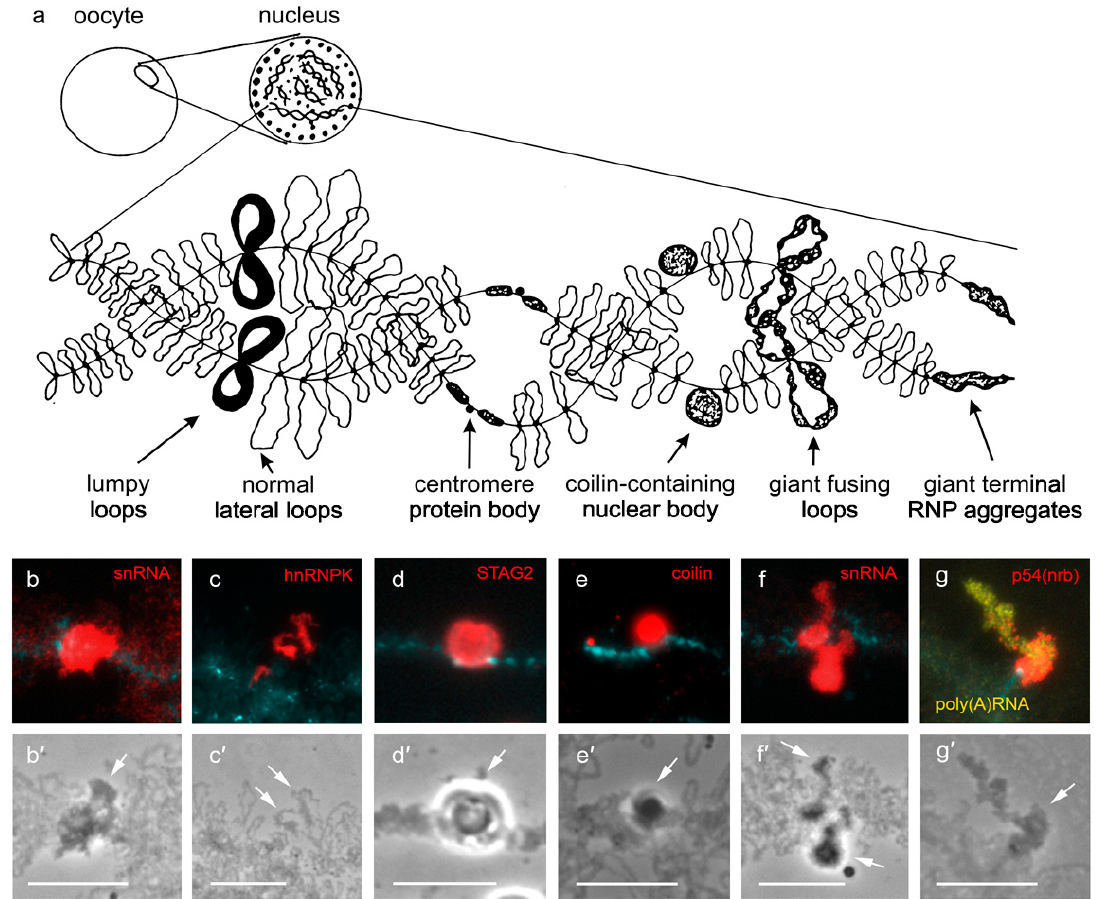
Figure 1. Locus-specific nuclear domains on lampbrush chromosomes. ( a ) Schematic drawing of a lampbrush chromosome with various locus-specific nuclear bodies and domains. Lumpy loops, ‘normal’ lateral loops, centromere protein bodies, coilin-containing nuclear bodies, giant fusing loops and giant terminal RNP aggregates (GITERA) are shown. ( b ) Lumpy loops forming on lampbrush chromosome K of the lake frog ( Pelophylax ridibundus ) after immunostaining with antibodies against splicing snRNA (red). ( c ) ‘Normal’ lateral loops bearing transcription units of 41 bp tandem repeat CNM on lampbrush chromosome 3 of chicken ( Gallus gallus domesticus ) after immunostaining with antibodies against hnRNP K (red). ( d ) Centromere protein body on lampbrush chromosome of the chaffinch ( Fringilla coelebs ) after immunostaining with antibodies against STAG2 protein of cohesin complex (red). ( e ) Coilin-containing body on lampbrush chromosome B of the lake frog ( P. ridibundus ) revealed by immunostaining with antibodies against coilin (red). ( f ) Giant fusing loops forming on lampbrush chromosome H of the lake frog ( P. ridibundus ) after immunostaining with antibodies against splicing snRNA (red). ( g ) GITERA on lampbrush micro-chromosome of pigeon ( Columba livia ) accumulate poly (A) + RNA revealed by FISH with oligo-dT (yellow) and paraspeckle protein p54 (nrb)/NONO (red). Chromosomes are counterstained with DAPI (cyan). ( b ′ – g ′ )—corresponding phase contrast images. Scale bars—10 μ m.